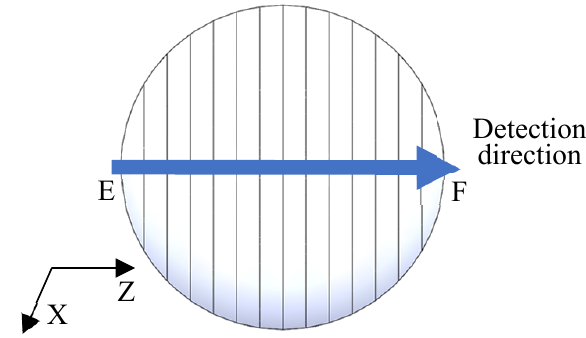
Figure 9. Area of detection for convex grating.